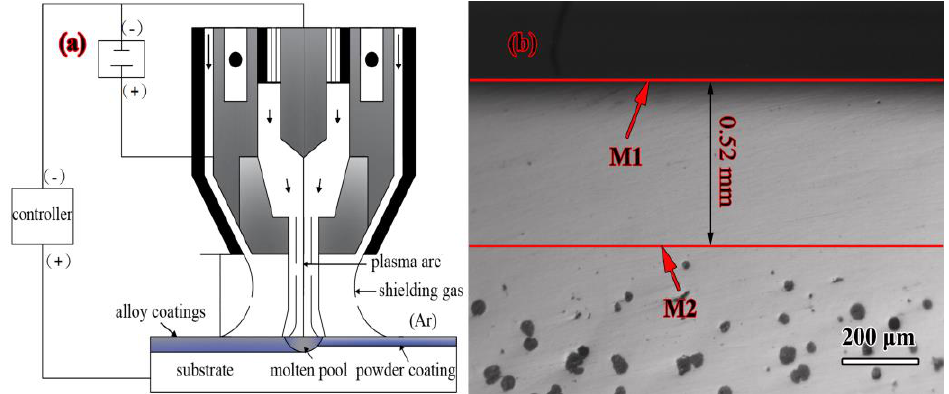
Figure 2. Schematic diagram of remelting treatment and determined research position: ( a ) the processing principle of plasma transferred arc, ( b ) the position definitions of M1 and M2 in this paper.